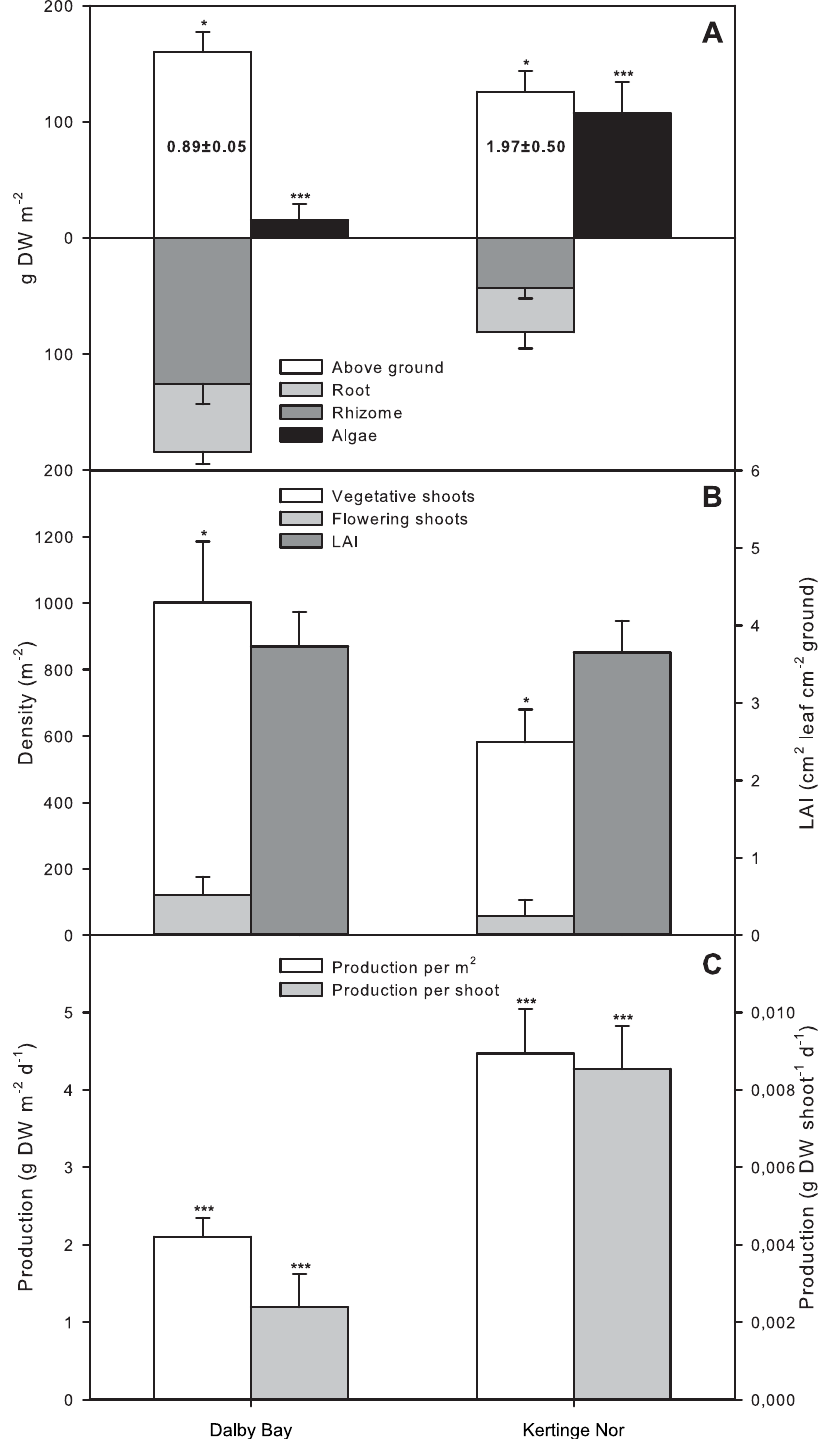
Fig 2. Zostera marina meadow characteristics in Dalby Bay and Kertinge Nor. Values are mean ± SE. Asterisks indicate statistical significant differences based on t-tests ( * = 0.05, *** = 0.001). For stacked columns the statistics refer to the summed value. (A) Z . marina and algal biomass. Numbers in columns are above to below ground biomass ratios. (B) Z . marina shoot density and leaf area index. (C) Z . marina above ground